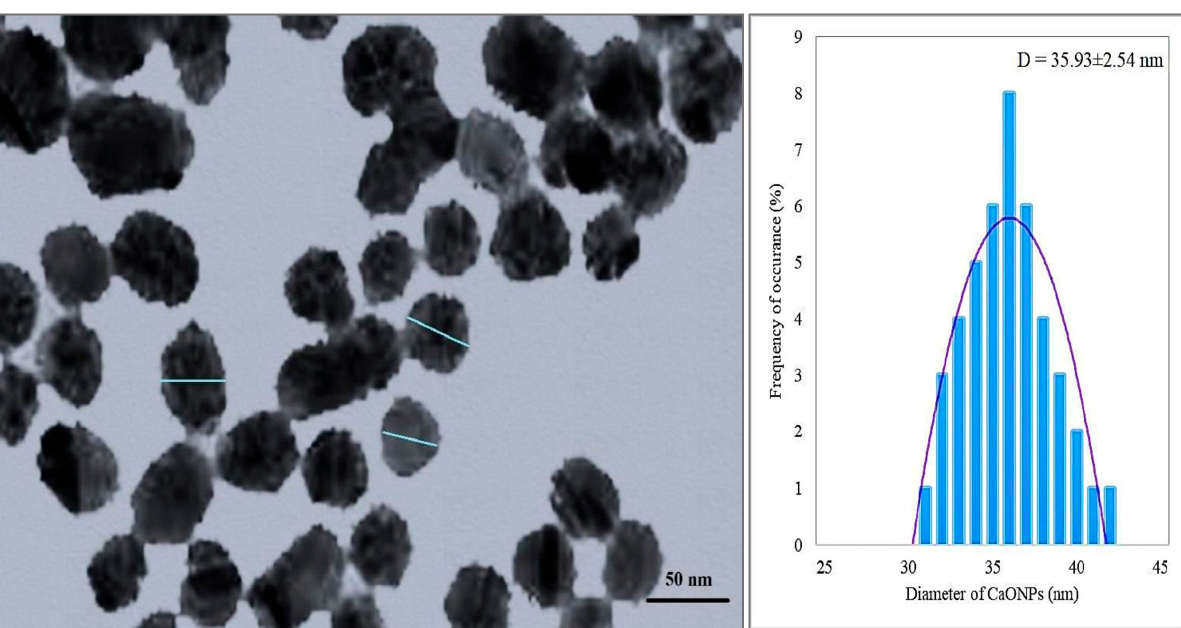
Figure 2. The transmission electron micrograph (TEM) of calcium oxide nanoparticles. D—Diameter of calcium oxide nanoparticles expressed as mean ± SEM.